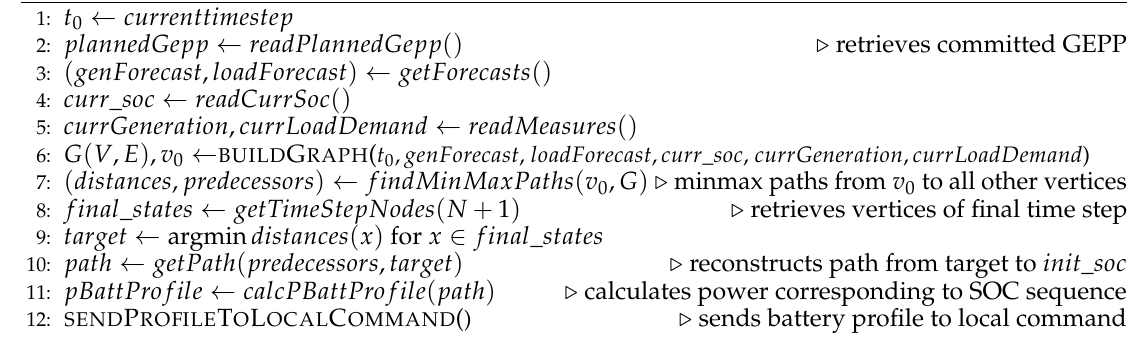
Algorithm 3 Pseudo-code of the Online Replanning algorithm.